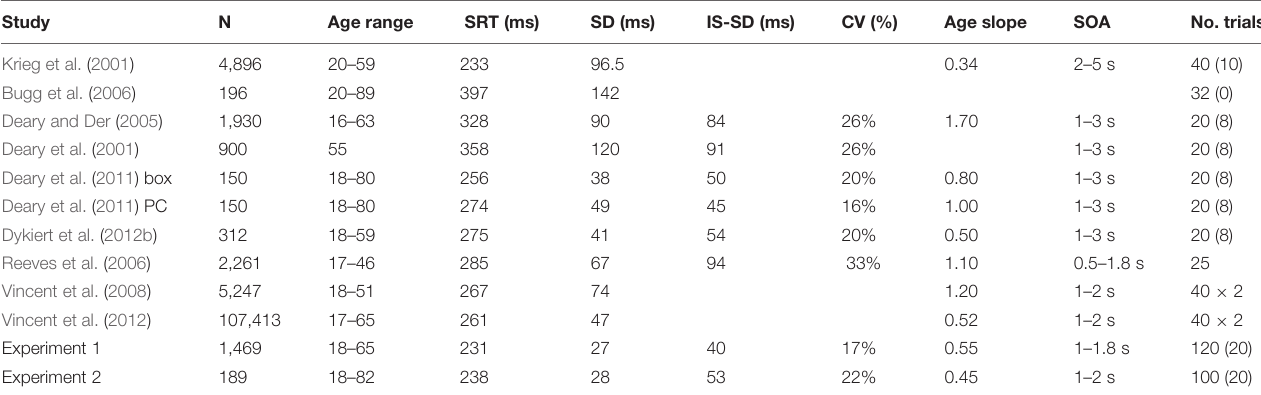
TABLE 1 | Studies of age-related changes in visual simple reaction time (SRT).